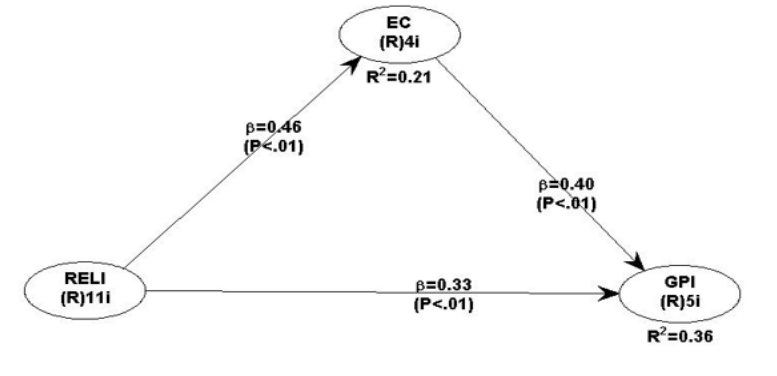
Figure 1: Final Structural